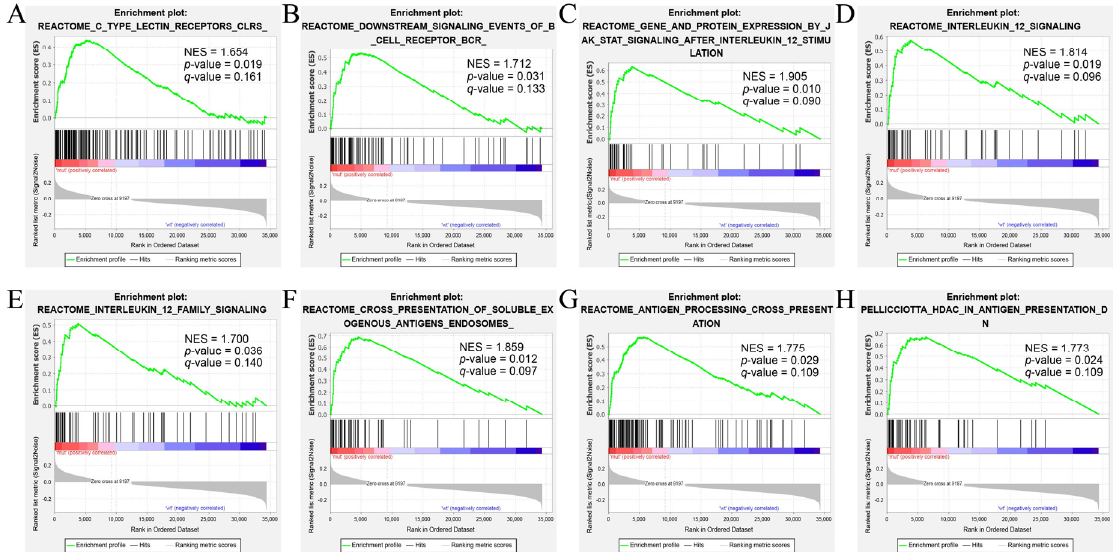
Figure 4. Immune-related pathways enriched in CSMD1-mut samples using GSEA program. ( A ) Reactome C-type lectin receptors (CLRs), ( B ) Reactome downstream signaling events of B cell receptor (BCR), ( C ) Reactome protein expression by JAK-STAT signaling after interleukin 12 stimulation, ( D ) Reactome interleukin 12 signaling, ( E ) Reactome interleukin 12 family signaling, ( F ) Reactome presentation of soluble exogenous antigens endosomes, ( G ) Reactome antigen processing cross presentation, and ( H ) HDAC in antigen presentation down. NES, Normalized enrichment score. P-value has been marked in each